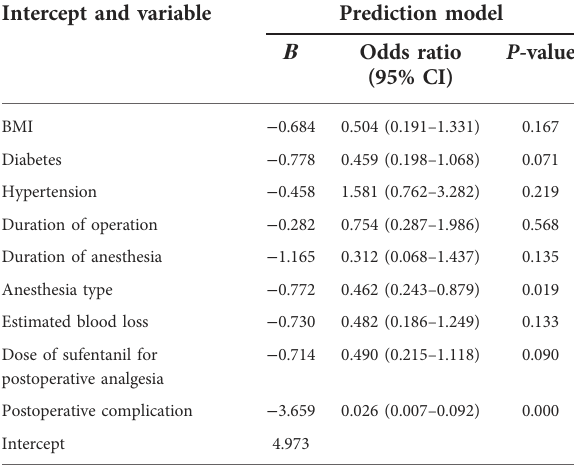
TABLE 2 Prediction factors for prolonged PLOS in lumbar fusion